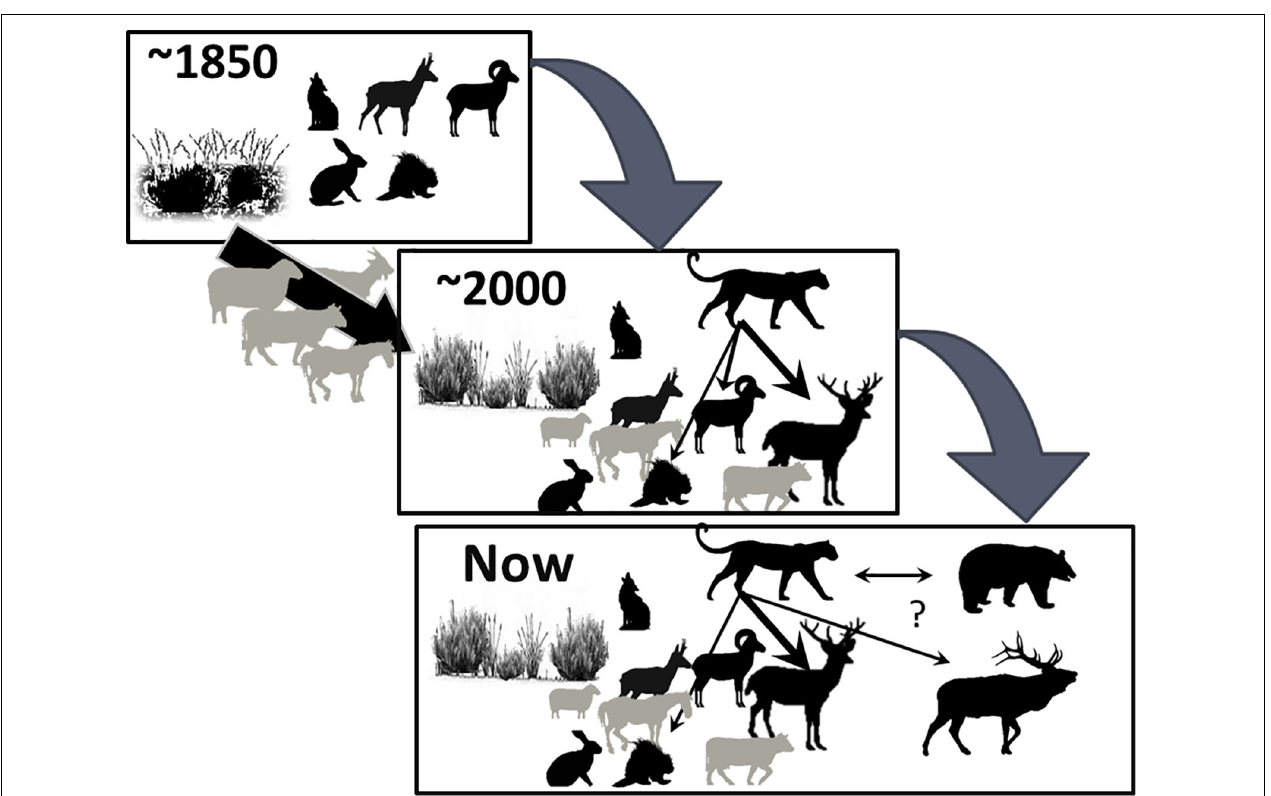
FIGURE 5 | Schematic of temporal change in a prey–predator food web in the Great Basin Desert, United States, illustrating how livestock and vegetation altered bottom-up processes to facilitate a new apex carnivore. The arrow width reflects the strength of predation intensity. The relative size of the icons depict a positive or a negative relationship, and in the lower illustration are pumas, black bear, coyotes, pronghorn, bighorn, mule deer, elk, hares, porcupines, domestic sheep, domestic horses, and